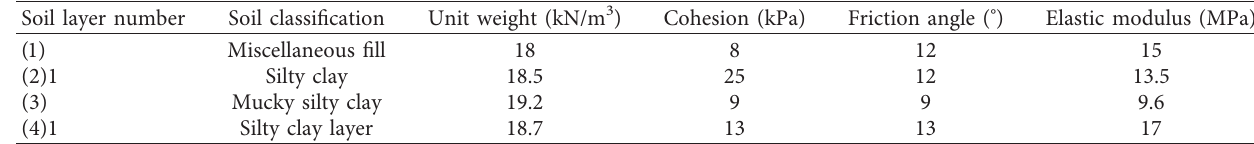
Figure 1: Position relationship between foundation pit and tunnel. (a) Plan view. (b) Profile view. Table 1: Physical and mechanical parameters of